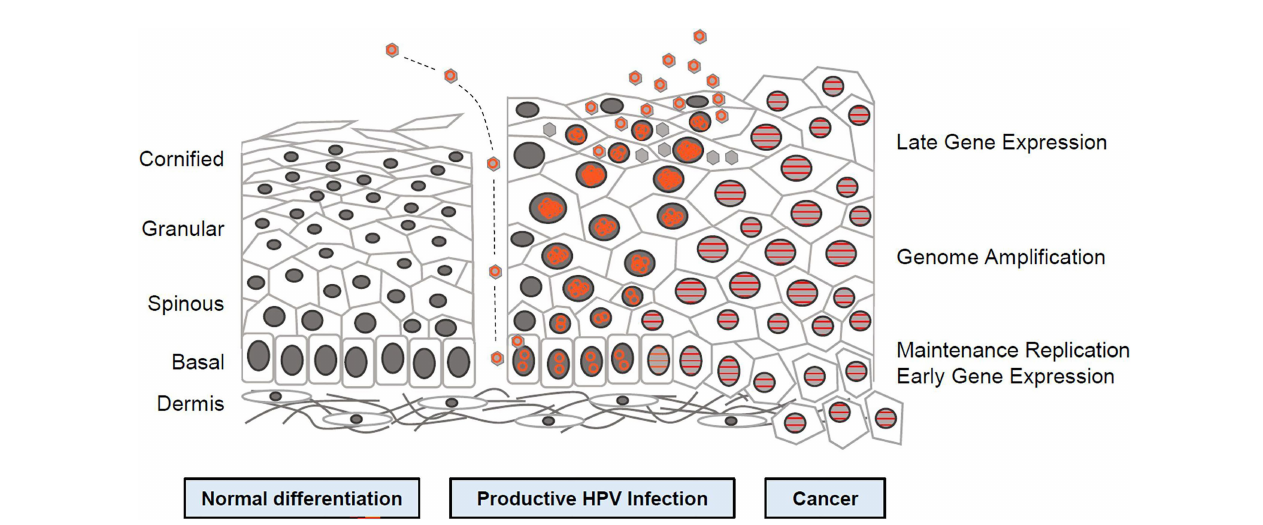
FIGURE 1 Human papillomavirus (HPV) life cycle and cancer (12). Cartoon depicting normal stratified cervical epithelium (left), HPV infected epithelium (center), and HPV induced cancer (right). Epithelial layers are indicated on the far left and HPV life cycle stages are indicated on the far right. Episomal genomes are shown as orange circles and integrated genomes shown as orange stripes. Left: Normal keratinocyte differentiation. Basal cells divide and daughter cells migrate upward, beginning the differentiation program. As differentiation proceeds, cells exit the cell cycle. Fully keratinized squames slough off from the apical surface. Middle: Productive HPV Infection: HPV virions gain access to basal cells via microwounds. The viral genomes migrate to the nucleus, where they are maintained at approximately100 copies/cell. As daughter cells begin differentiation, viral genomes are amplified. Cell nuclei are retained and chromatin is activated to support viral DNA replication. Right: Cancer. Viral genomes often integrate into the host genome and E6/E7 expression is increased, leading to enhanced proliferation and accumulation of cellular mutations. Cellular differentiation is lost and cancerous cells invade into the dermal layer along with neighboring tissues